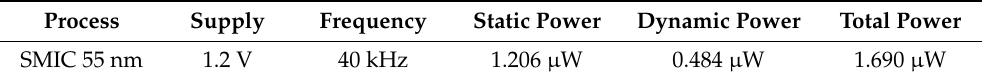
Table 1. Power consumption results.